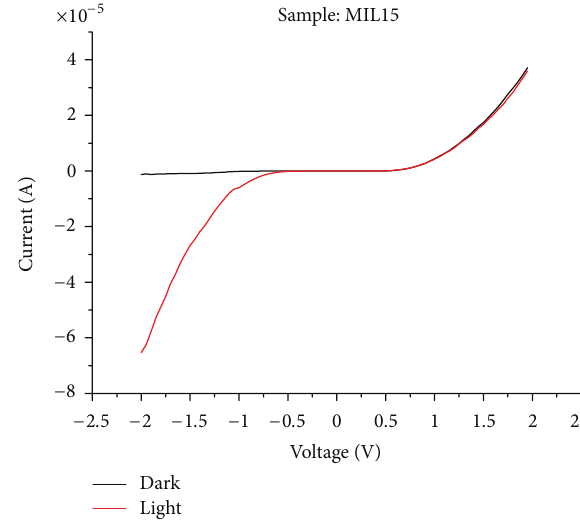
Figure 5: 𝐼/𝑉 scans of the samples in dark and under